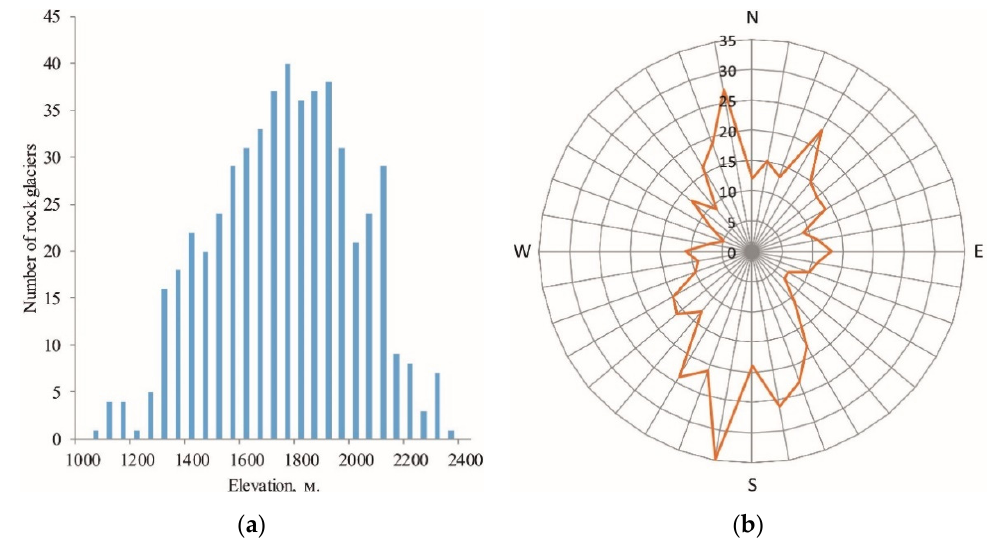
Figure 4. Distribution of mean absolute altitudes ( a ) and the exposure of the slopes ( b ) of rock glaciers on the Suntar-Khayat Range.